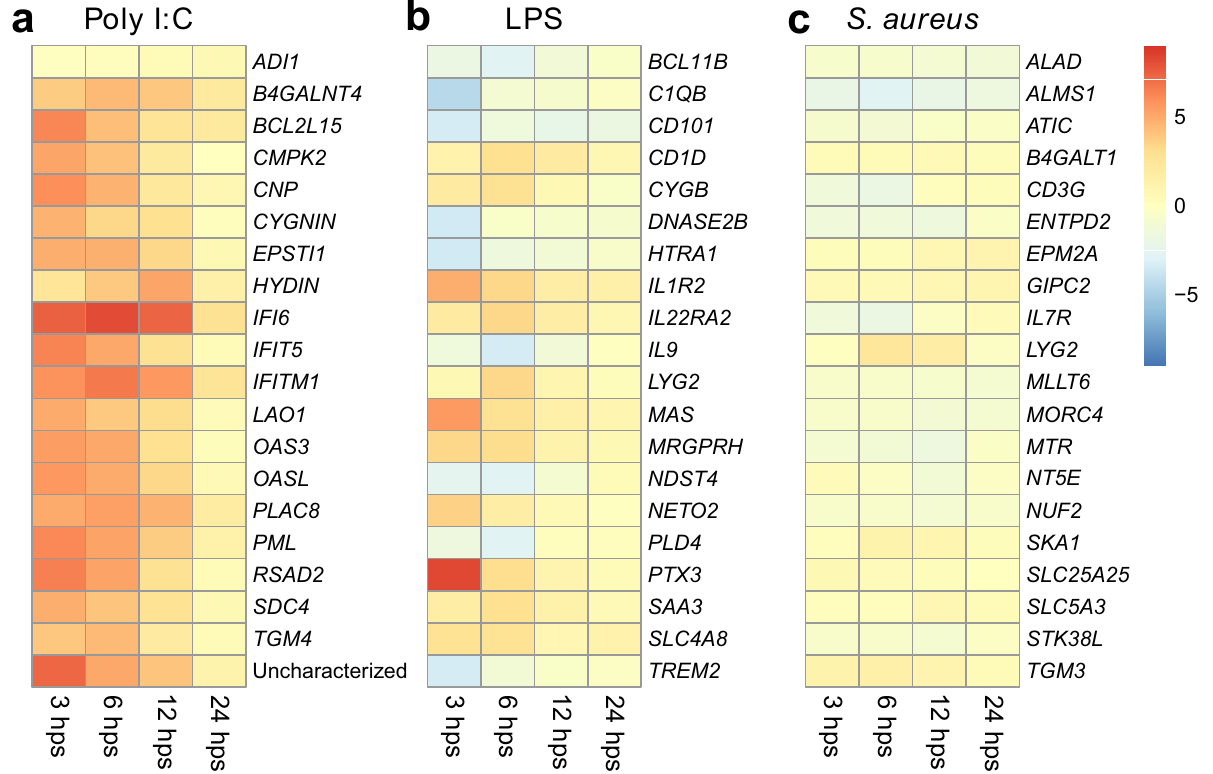
Figure 3. Heatmap illustrating the log2 fold change of the differentially expressed genes (rows) that were most up- or downregulated for each time point (column) and treatment group (FDR < 0.05). Red indicates that the gene expression was higher-, and blue indicates that the gene expression was lower in the treatment group than in the control group. For genes that could not be assigned a gene name from the mallard genome, hits identified through the BLAST search is shown (for more details see Supplementary Information Tables S4–S7 and Supplementary Dataset S4. Gene name changed from IFITM3 to IFITM1, following the suggested nomenclature in Blyth, et al. 61 . All DEGs from the treatment groups are listed in Supplementary Datasets